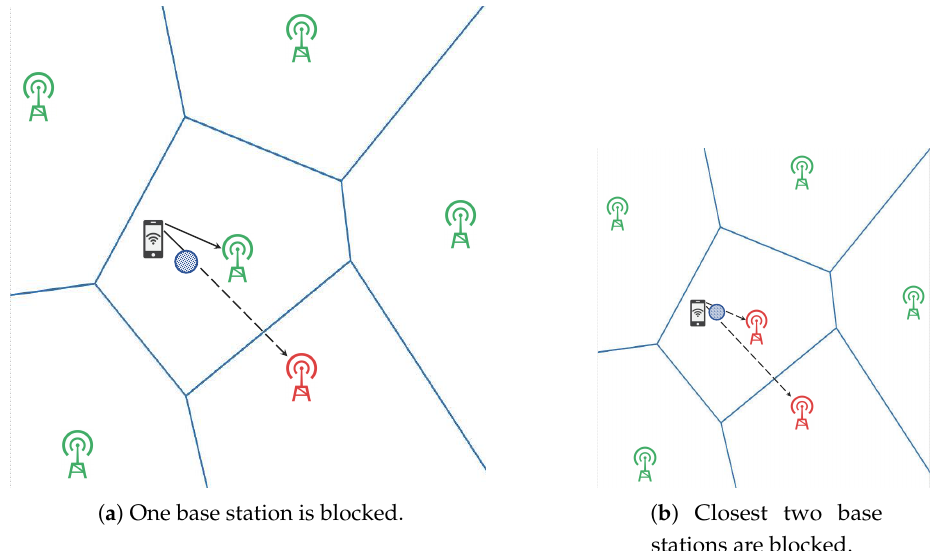
Figure 1. Example network topology with two different blockage scenarios. The source transmitter is the mobile device shown in the central cell. Its signal is transmitted to its closest two base stations. The solid line indicates the link is line-of-sight (LOS), while the dashed line indicates the link is non-LOS